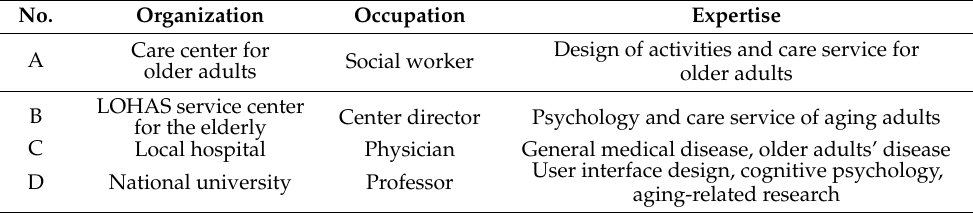
Table 3. List of the backgrounds of the invited experts interviewed in this